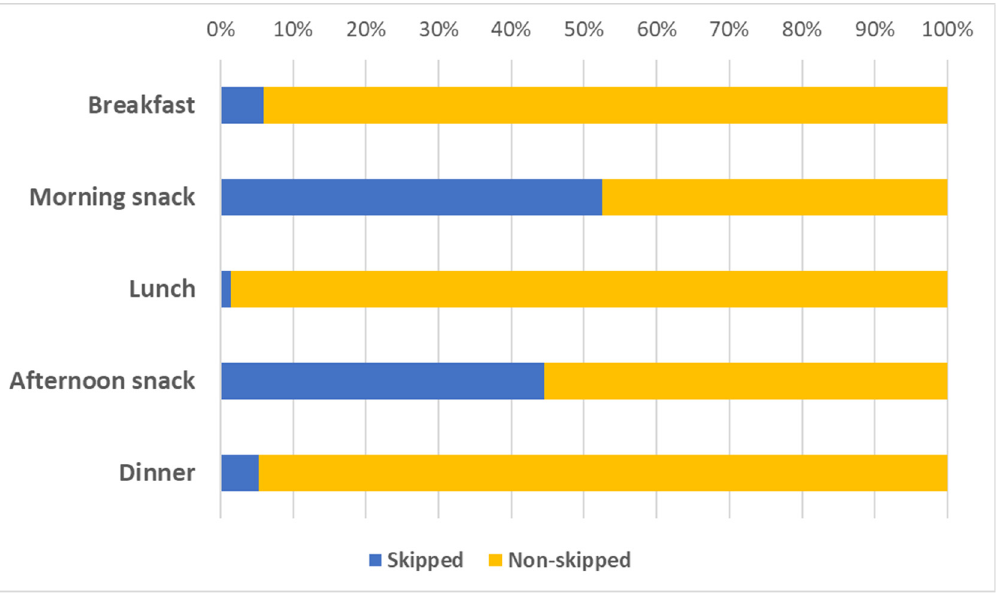
Figure 2. Proportion of skipped and non ‐ skipped eating episodes for type of meal. Blue bars represent the proportion of skipped meals for each type of meal. Yellow bars represent the proportion of non ‐ skipped meals for each type of meal.